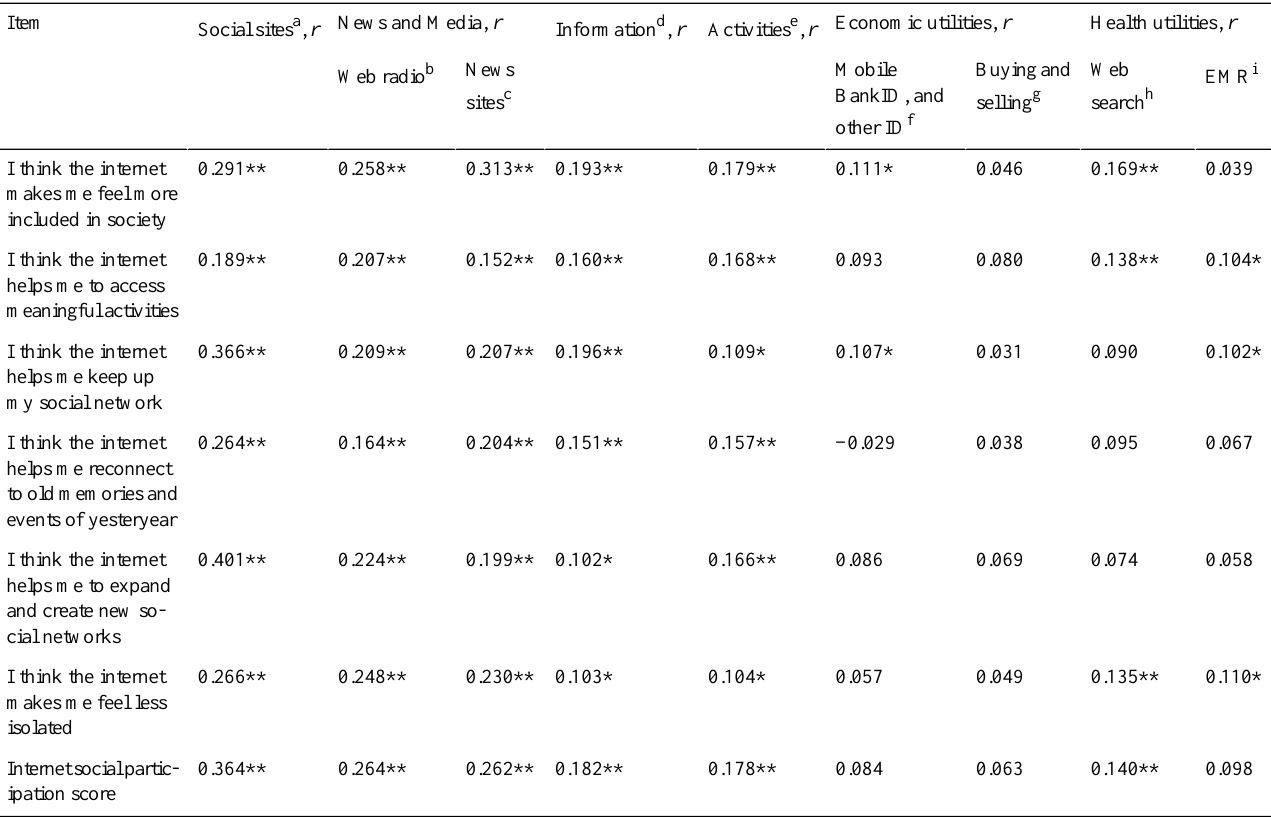
Table 5. Pearson correlations between the social participation score (and its individual question items) to variables measuring a variety of internet-related